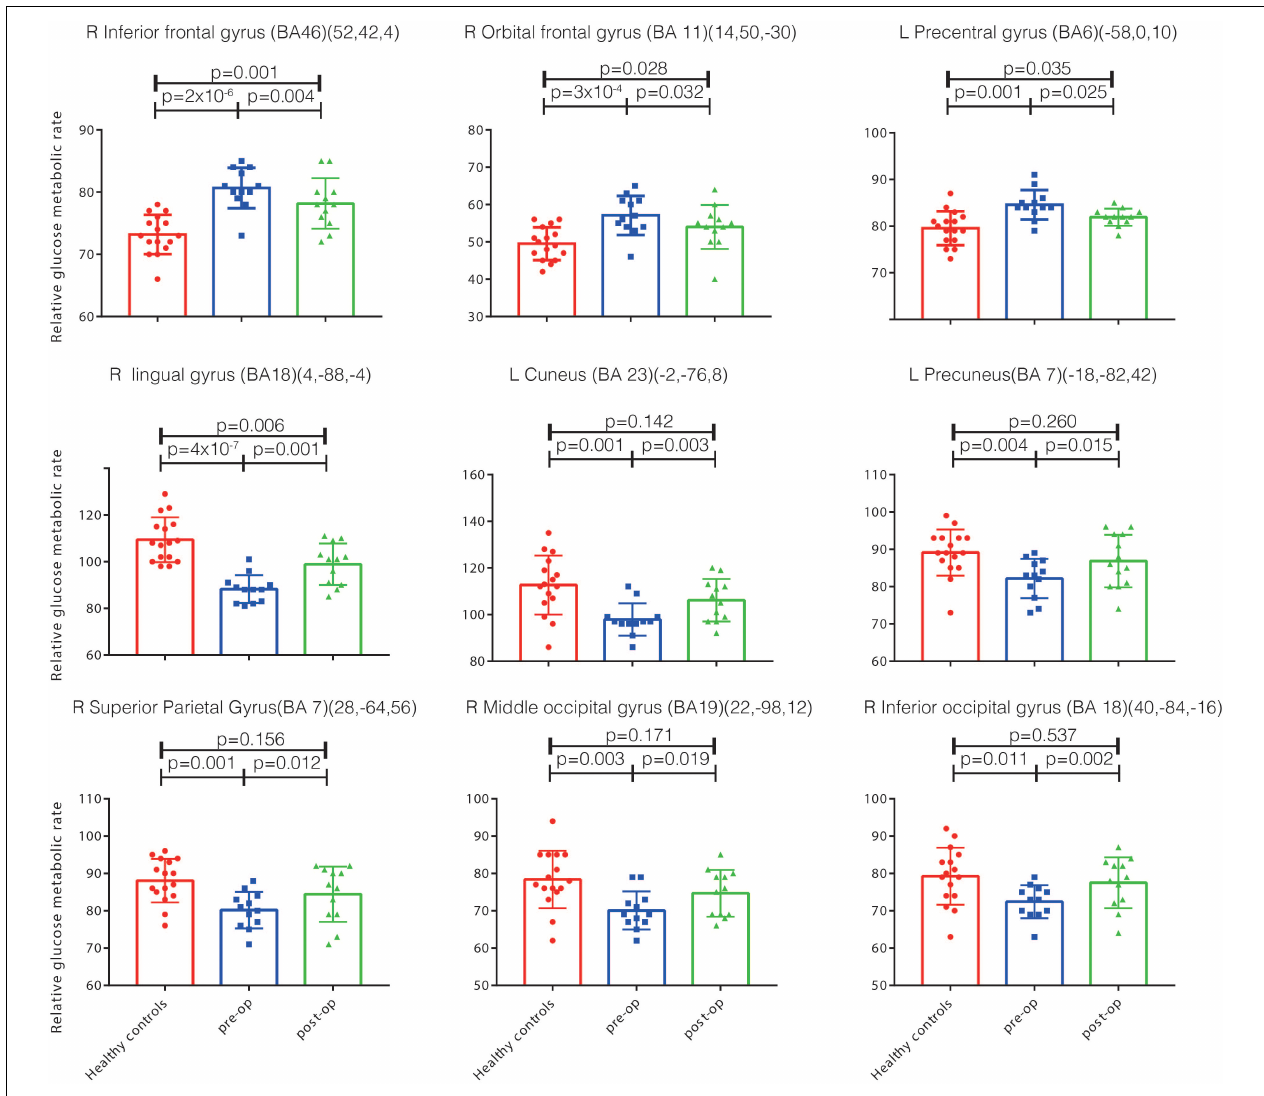
FIGURE 2 | The relative glucose metabolism rates in the health controls and in patients pre-op and post-op. Significant metabolism differences exist between the health controls and pre-op PD-TRD patients ( p < 0.05), and between the pre-op and post-op patients ( p < 0.05). However, no significant metabolism differences exist between the post-op patients and health controls in the left cuneus, precuneus, right inferior occipital gyrus, middle occipital gyrus, superior parietal gyrus ( p > 0.05). Inf., inferior; Sup., superior; BA, Brodmann’s area; post-op, post-operation; pre-op, pre-operation; PD, Parkinson’s disease; DBS, deep brain stimulation; PD-TRD, Parkinson’s disease with treatment-resistant depression; OFC, orbitofrontal